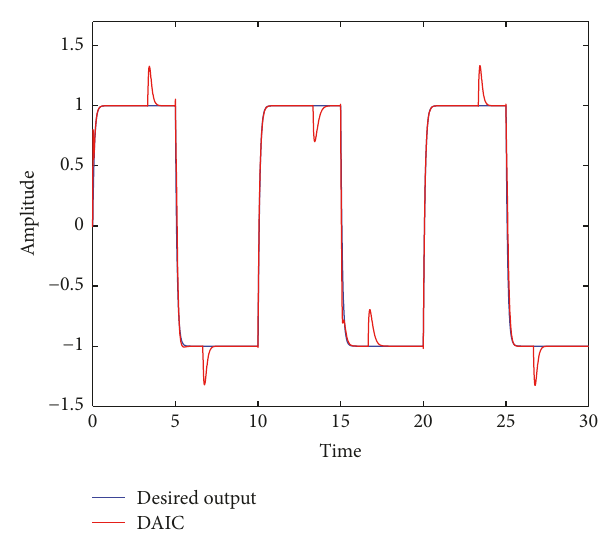
Figure 16: Desired output tracking in